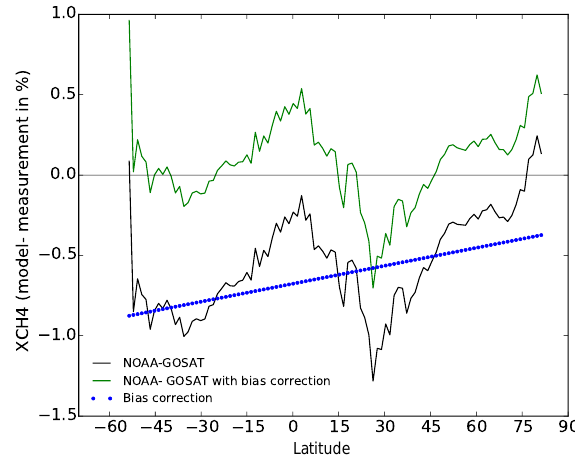
Figure A3. NOAA-based bias correction applied to X ratio in the RATIO